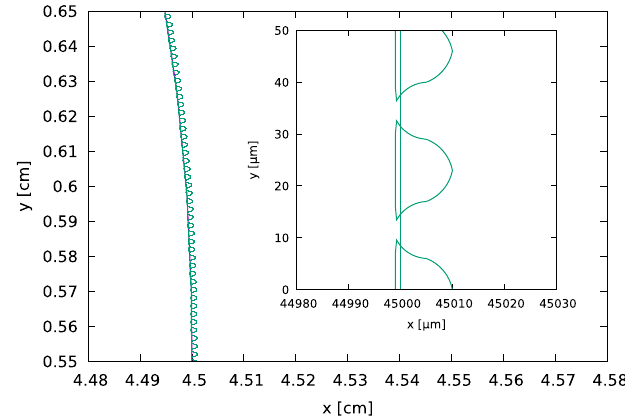
FIG. 5. Schematic diagram of the 10 - μ m-deep grooves on the CESR vacuum chamber wall used in the photonreflectivity model. The simulated vacuum chamber is the union of geometric